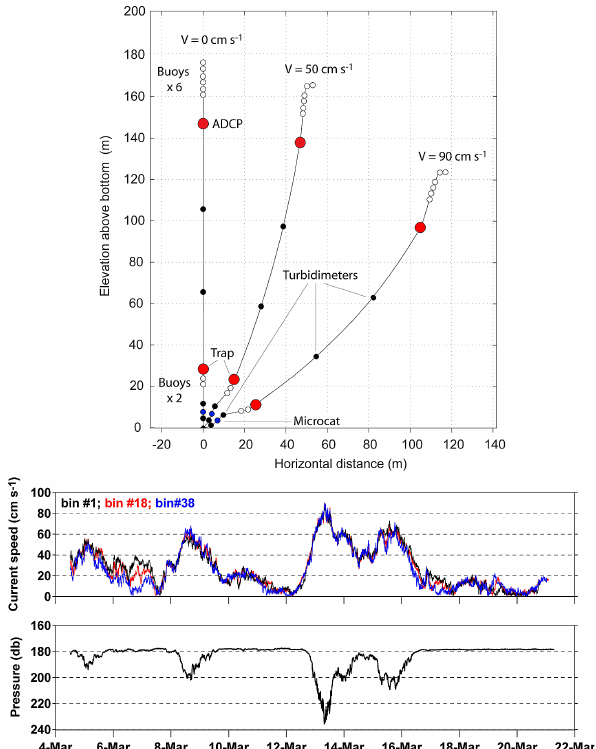
Fig. 2. Top: mooring dynamics as calculated by the Mooring Design and Dynamics software under three selected current speeds; bottom: pressure and current speeds measured by an ADCP attached 160m above the bottom to the temporary mooring line (SF2) that expe- rienced the strongest currents. Current speeds correspond to three selected ADCP bins: the topmost bin and the two more critical bins corresponding to the position of Seapoint turbidimeters attached to the